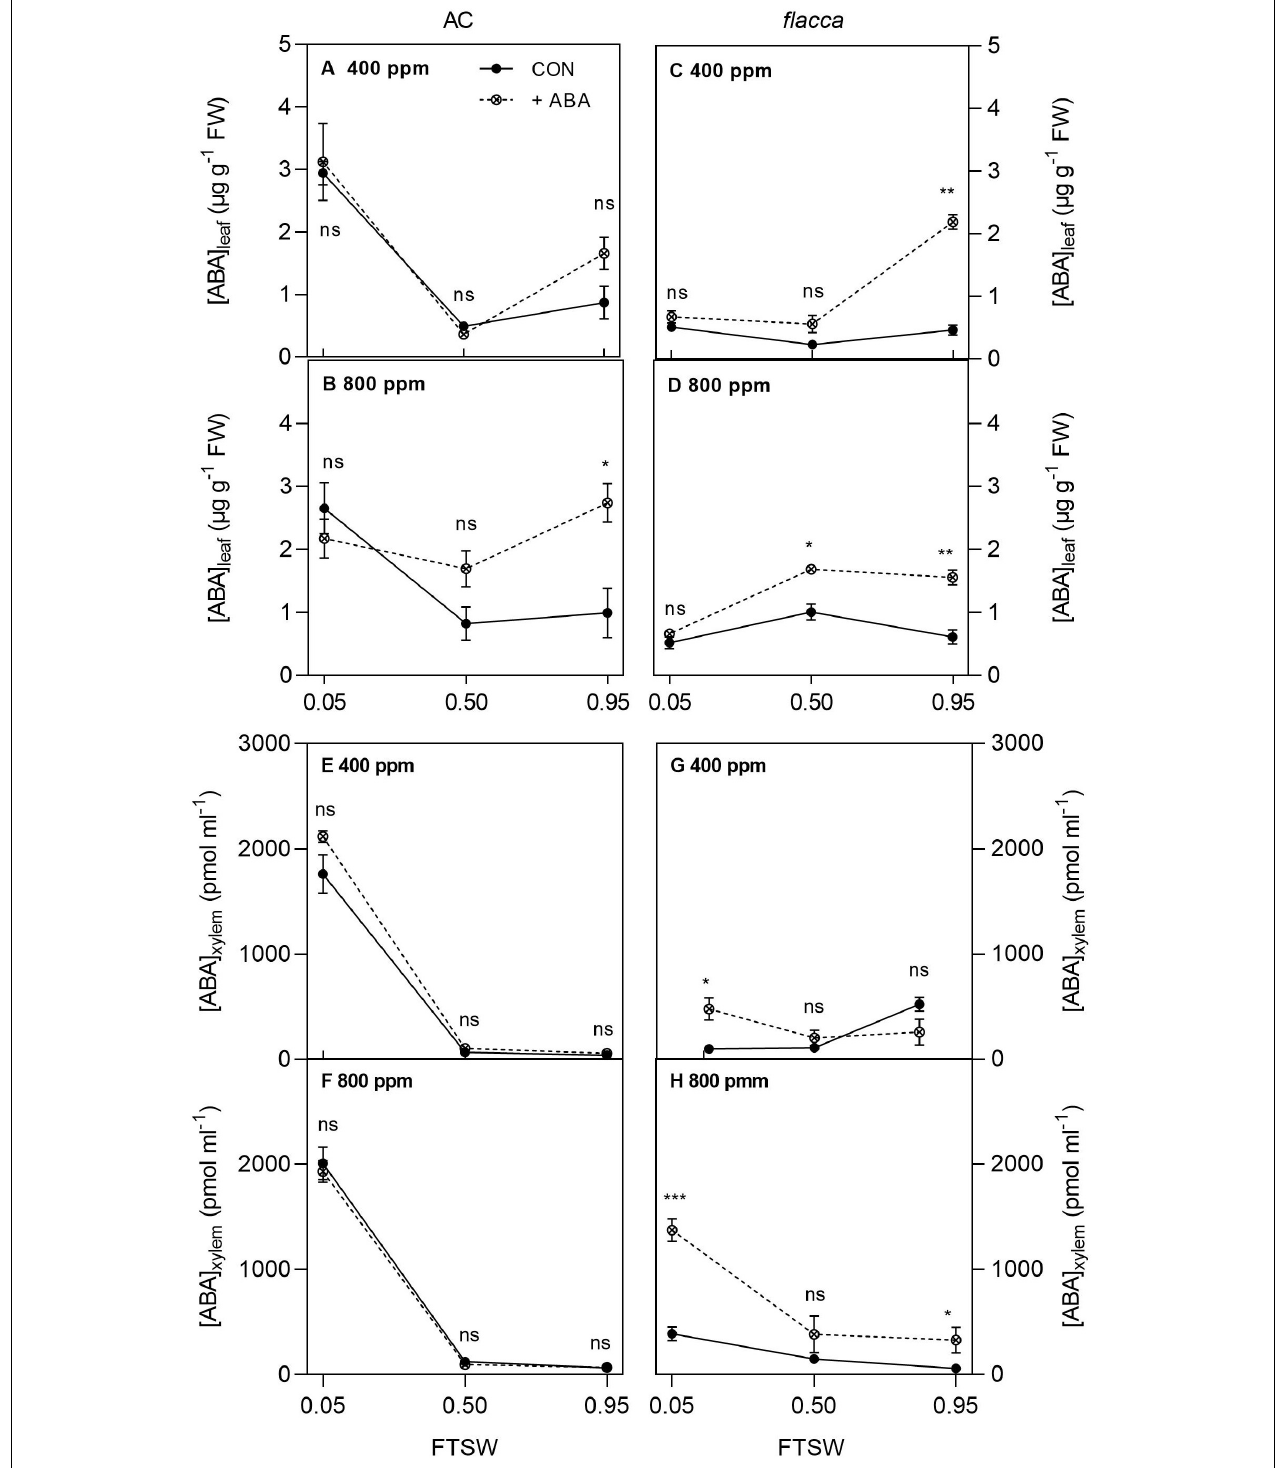
FIGURE 5 | Leaf and xylem sap ABA concentrations ([ABA] leaf , A–D ; [ABA] xylem , E–H ) in AC and flacca grown under ambient (400 ppm) and elevated (800 ppm) CO 2 concentrations during progressive soil drying. CON indicates the control treatment sprayed with water, +ABA indicates exogenous ABA application. FTSW indicates the fraction of transpiration soil water. *, **, and *** indicate the significant differences between ABA treatments by Student’s t -test at p < 0.05, p < 0.01, p < 0.001, respectively; ns denotes no significant difference. Error bars indicate the standard error of the means (S.E.) ( N = 3–4).